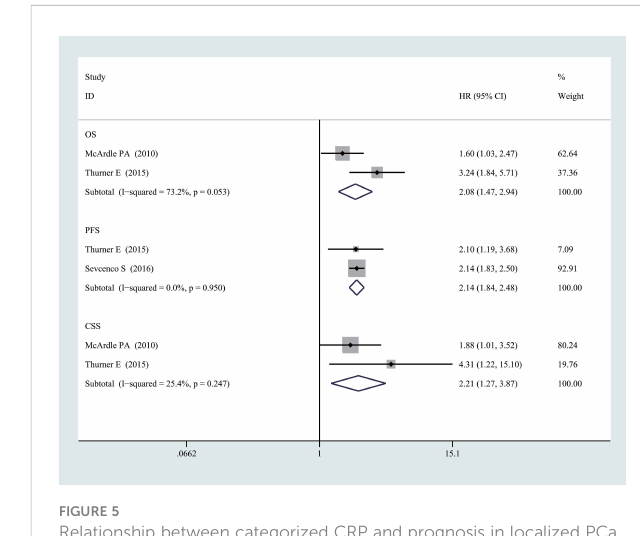
FIGURE 4 Relationship between categorized CRP and prognosis in mPCa. CRP, C-reactive protein; mPCa, metastatic prostate cancer.